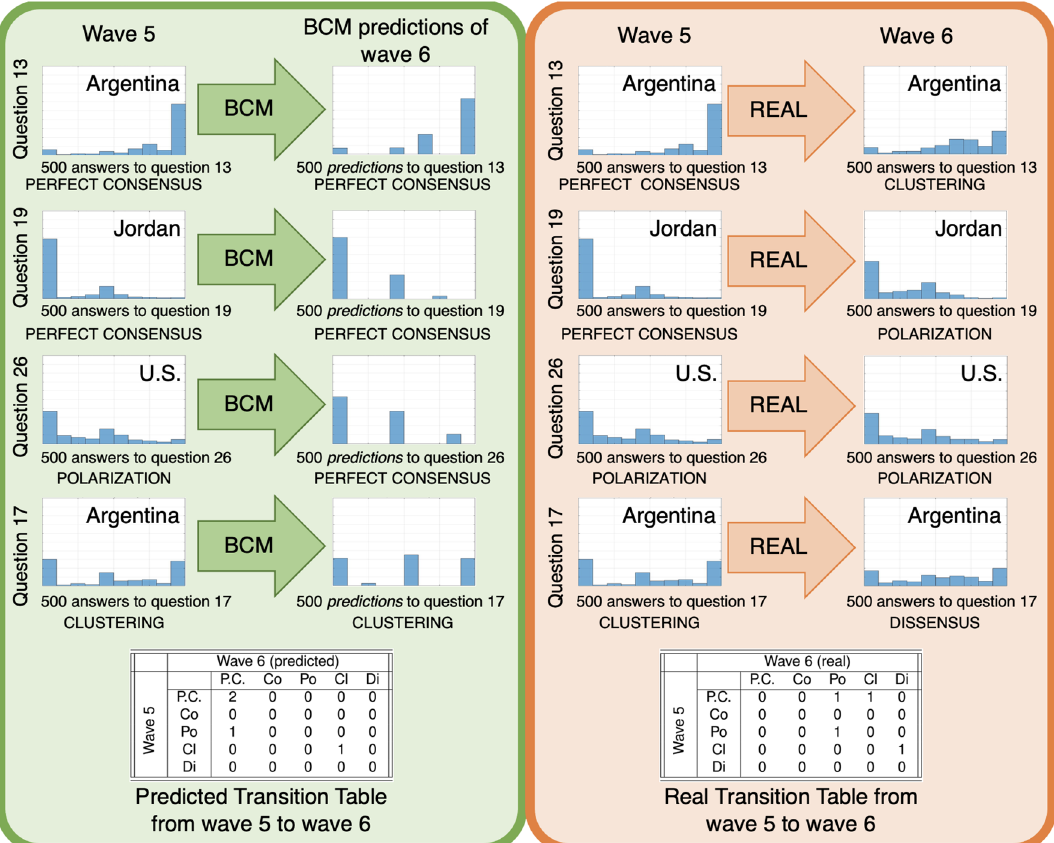
Figure 2. Simple example to illustrate the proposed approach: based on the answers to 4 questions administered to 500 people in two consecutive survey waves, the accuracy of the Bounded Confidence Model (BCM) can be assessed by comparing the predicted transition table (left) with the real transition table (right). In the tables P.C. is perfect consensus, Co is consensus, Po is polarization, Cl is clustering, and Di is